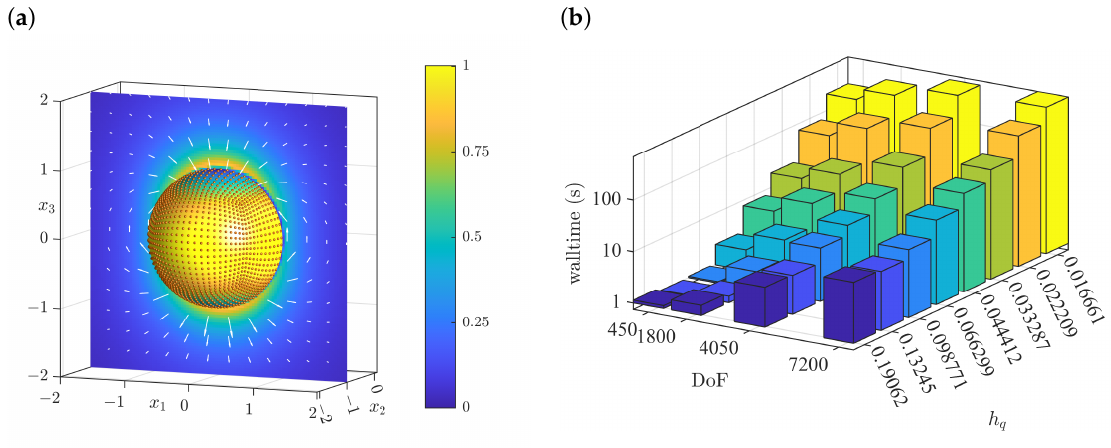
Figure 4. Slip velocity squirmer calculations. ( a ) Flow field around the slip velocity spherical squirmer. Shown are: collocation points (orange) and flow field (background colour and white arrows). Results calculated with 7200 degrees of freedom and h q = 0.0498. The sphere surface is coloured by slip velocity magnitude in the body frame. ( b ) Walltime for slip velocity squirming swimmer computation on a notebook computer and its dependence on force discretisation DoF and quadrature spacing h q